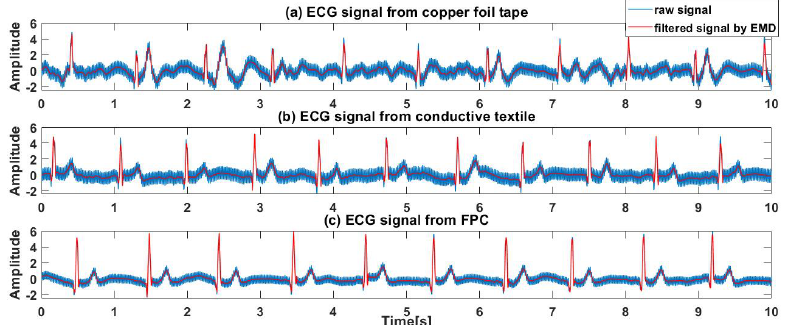
Figure 16. ECG signals of a subject side lying on a recliner: ( a ) ECG signals measured by copper foil tape. ( b ) ECG signals measured by conductive textile. ( c ) ECG signals measured by FPC.